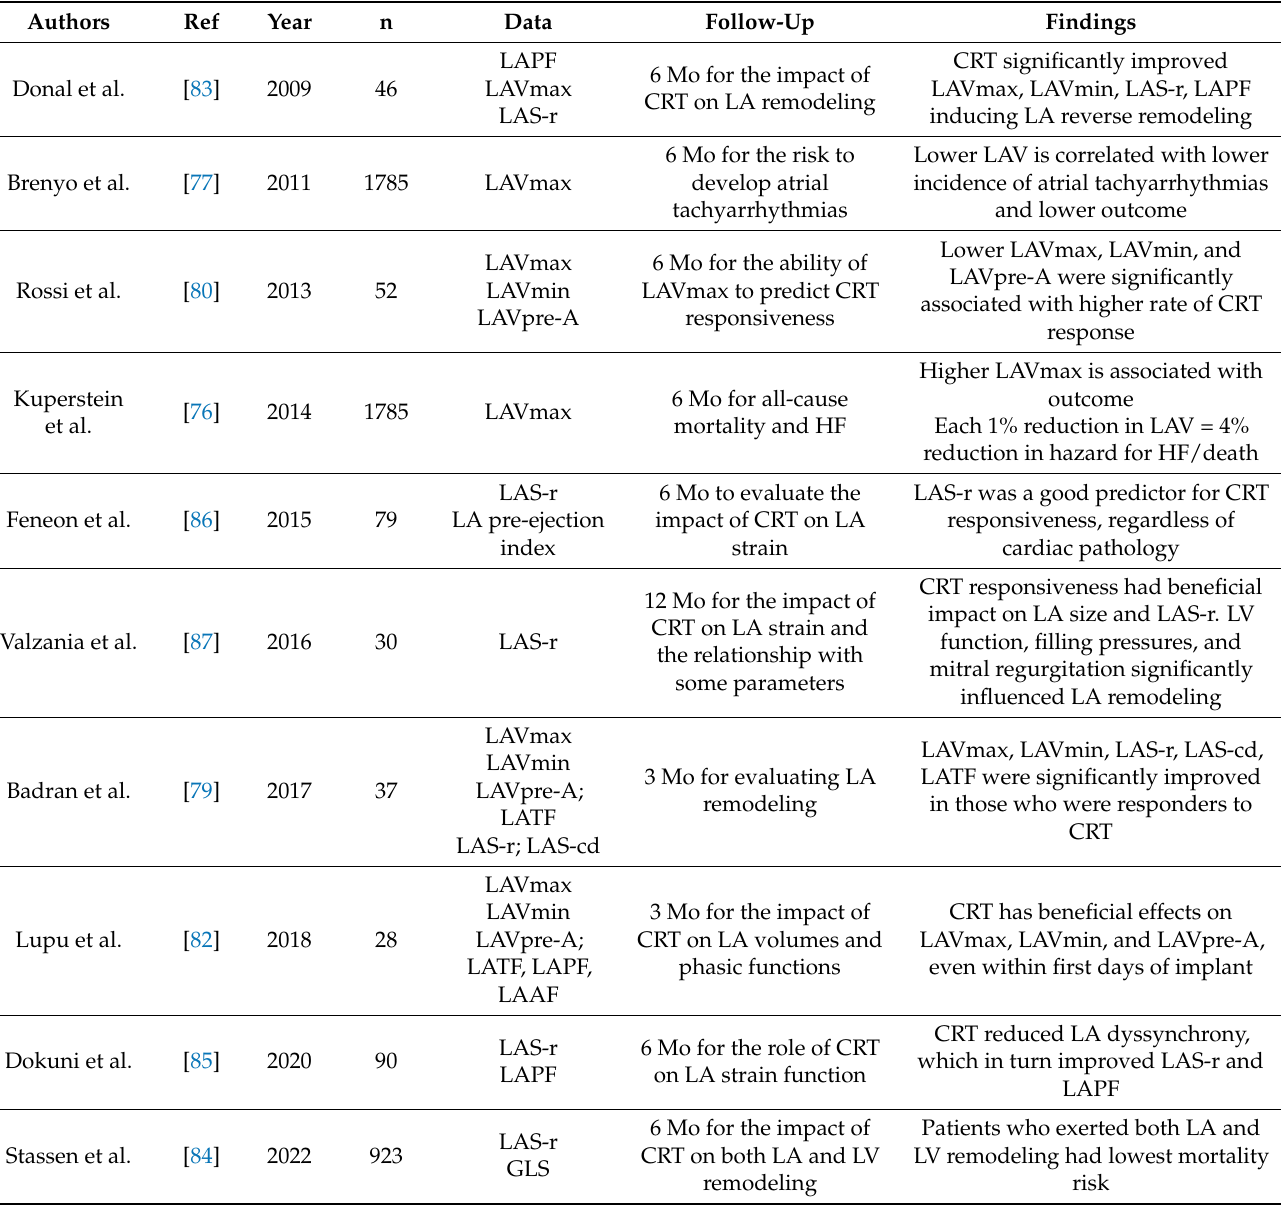
Table 2. Studies which evaluate the relationship between CRT and LA